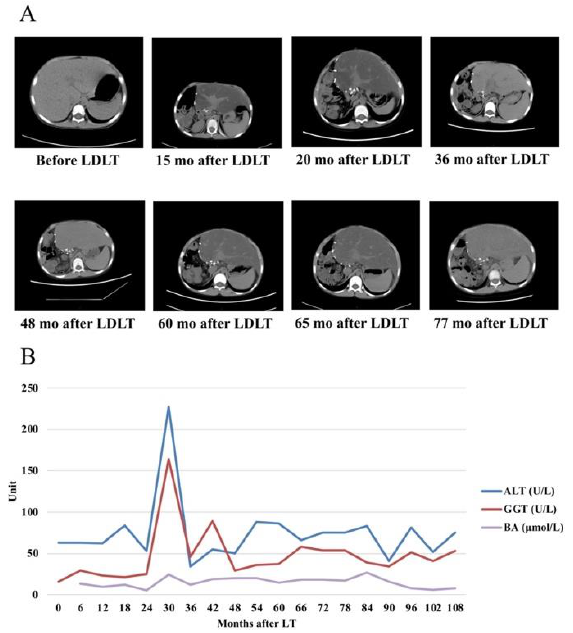
Figure 3. Allograft steatosis and liver function in one PFIC type I patient after LT. ( A ) Abdominal computed tomography (CT) examination before and after LT in one PFIC type I patient indicated the “remission–relapse circle” of steatosis in the allograft. Steatosis was firstly found 15 months after LT and was relieved at 36 months but reappeared and alleviated again at 60 months and 77 months, respectively. ( B ) Liver enzymes fluctuation has no relation with allograft steatosis. LDLT: living donor liver transplantation; ALT: alanine aminotransferase; BA: bile acid; GGT: γ -glutamyl transferase; mo: month.